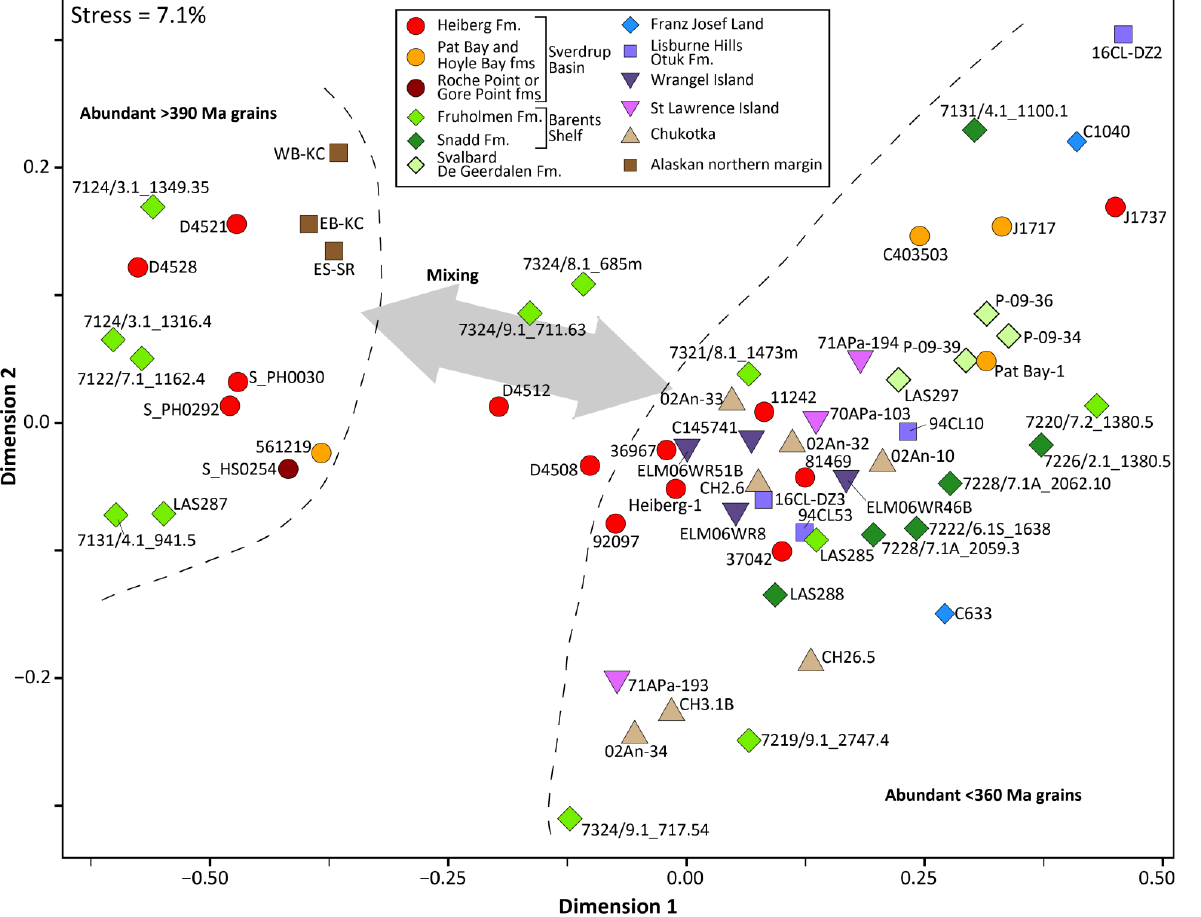
Figure 16. Multidimensional scaling plot showing the similarity/dissimilarity in detrital zircon U–Pb age spectra from Late Triassic samples of the wider Arctic region. The thick grey arrow indicates mixing between the two main sample clusters. See Figure 15 for the data sources used. The plot was drawn in R using the Provenance package [148]. Fm/fms = formation/formations.